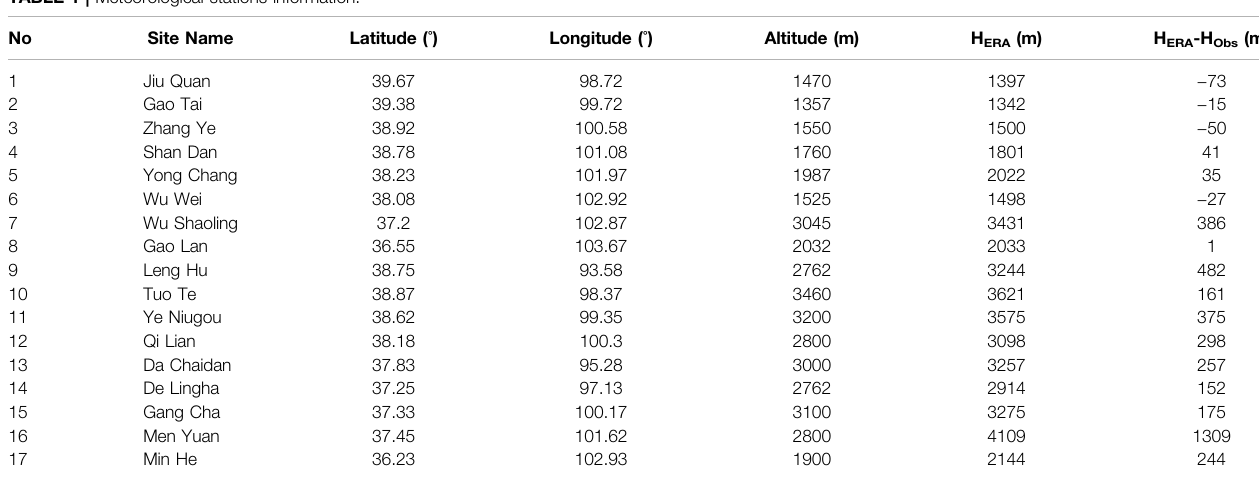
TABLE 1 | Meteorological stations information.